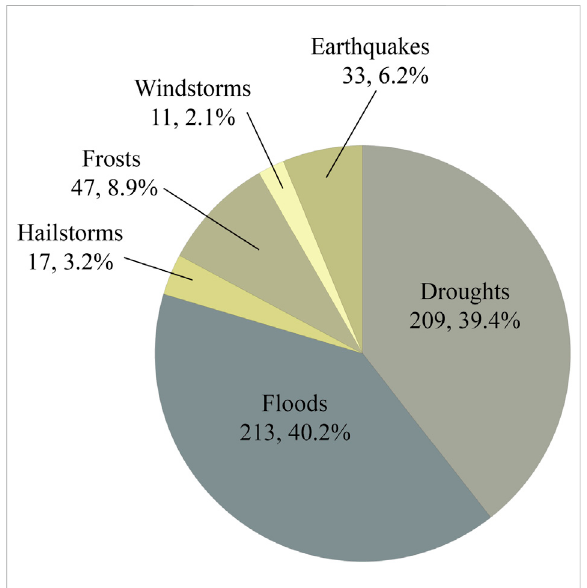
FIGURE 2 FrequencychartofthenaturaldisastersinHuizhouduringthe Ming and Qing